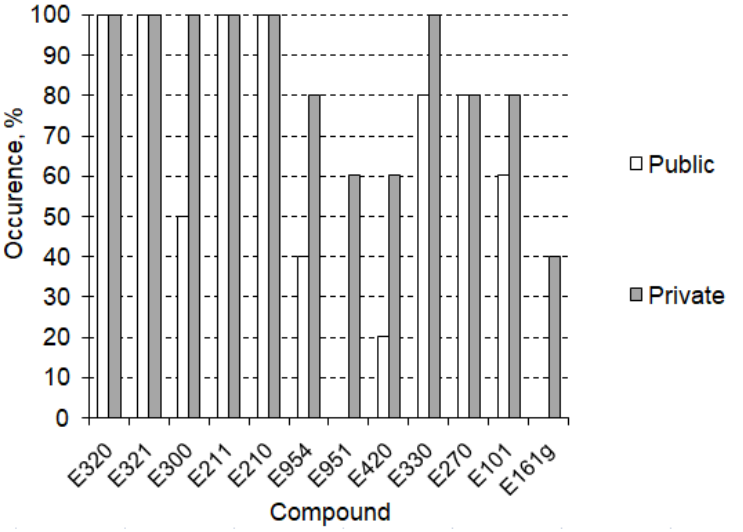
Figure 3. Food additives occurrence in public and private backyard swimming pools (N = 10).